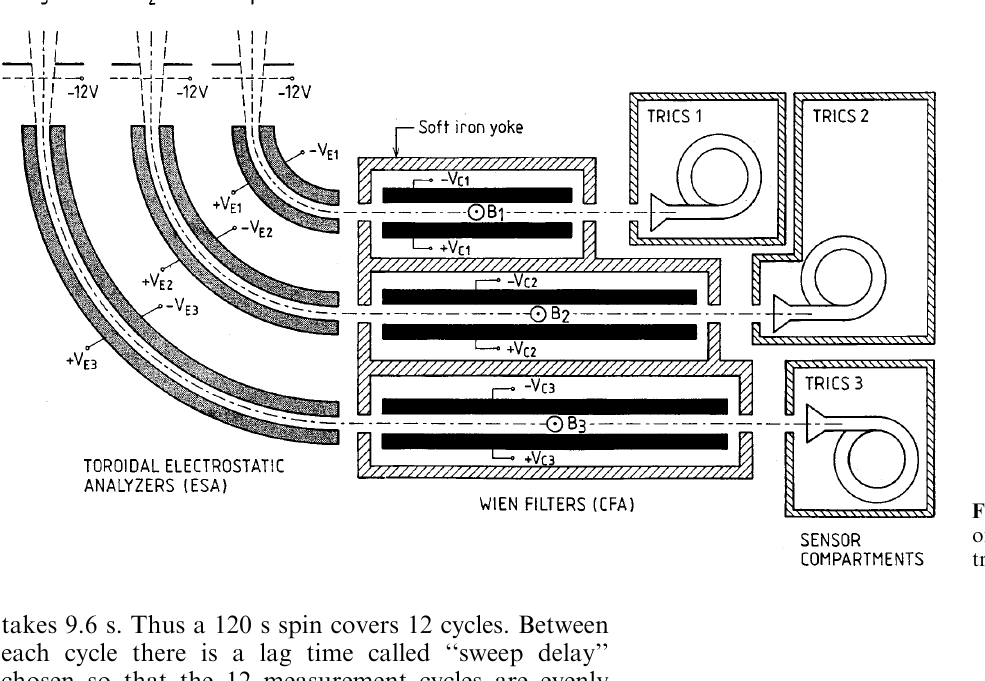
Fig. 4. General design principle of the positive ion mass spec- trometer TRICS